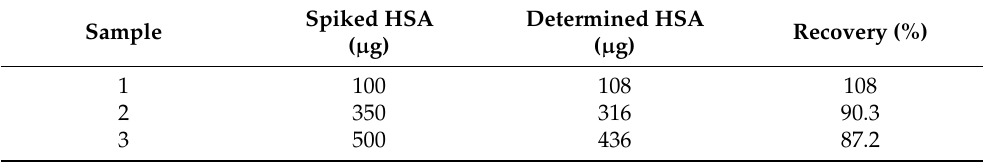
Table 2. Determination of HSA spiked in synthetic urine samples using S1